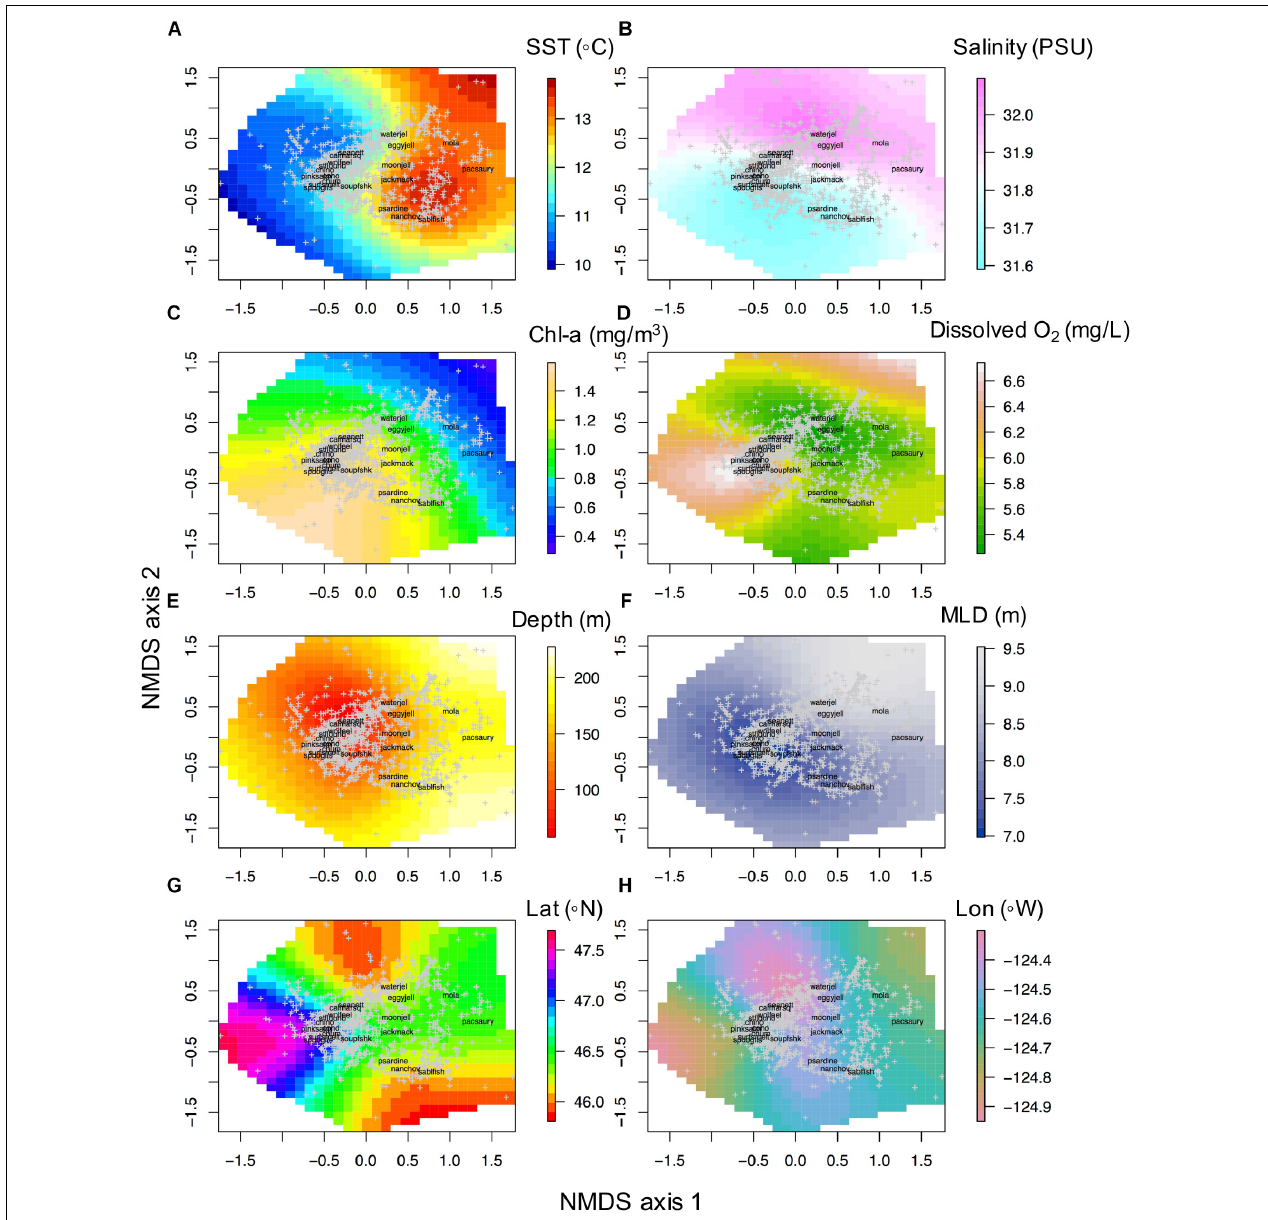
FIGURE 3 | Non-linear relationships of in situ CTD derived oceanographic variables with community structure NMDS axis 1 and axis 2. (A) Temperature at 10 m depth (SST, ◦ C), (B) salinity at 10 m depth (psu), (C) log (chlorophyll at 3 m depth) (mg/m 3 ), (D) dissolved oxygen concentration at 10 m depth (mg/L), (E) station bathymetric depth (m), (F) mixed layer depth (m), (G) latitude (Lat, ◦ N), (H) longitude (Lon, ◦